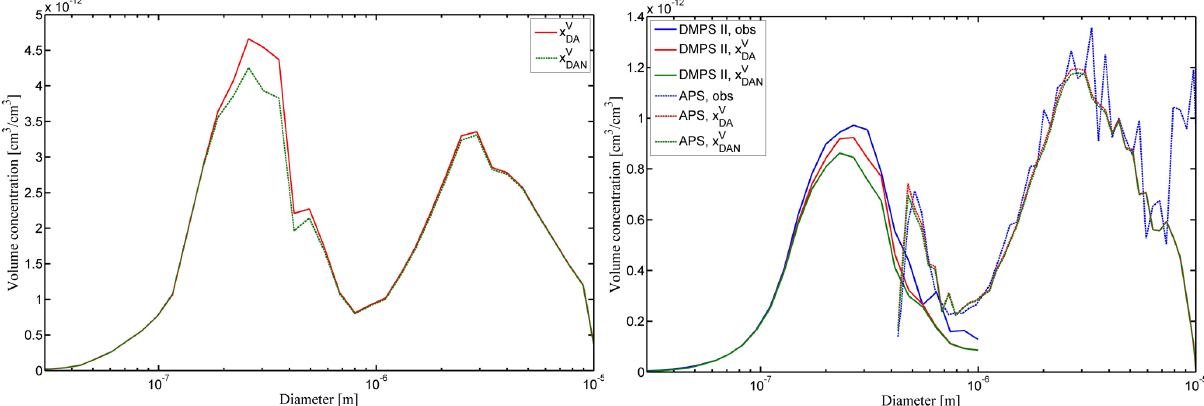
Fig. 6b. Same as Fig. 6a, but for 21:00LT.